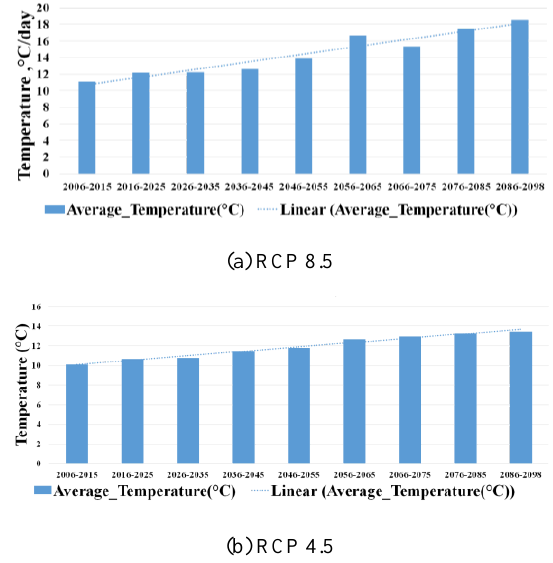
Figure 4. The decadal temperature trend data from GFDL- ESM2M - RCAv4 for Beas